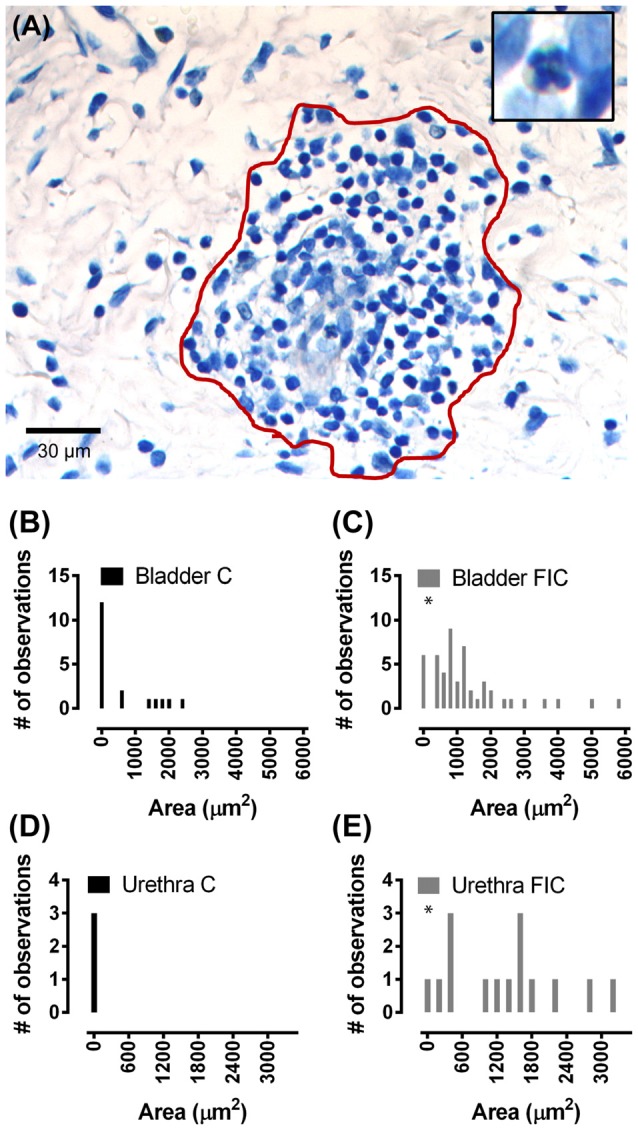
Immune cell infiltration in the LP of the bladder and urethra. (A) Example of leukocyte accumulation and area (red line) used for quantification, in the bladder of a FIC cat. Inset illustrates a neutrophil, characterized by the presence of dark small vesicles. (B,C) Histogram of area of immune cell infiltrate in the LP of the bladder from control (black; n = 17) and FIC (gray; n = 13) cats (Kolmogorov-Smirnov test, p = 0.02) cats showing only values smaller than 6000 μm2. One measurement in control and two measurements in FIC tissue were larger than 6000 μm2. Bin size 200 μm2. (D,E) Histogram of area of immune cell infiltrate in the LP of the urethra of control (black; n = 3) and FIC (gray; n = 7) cats (Kolmogorov-Smirnov test, p = 0.02) showing only values smaller than 3500 μm2. Bin size 200 μm2. There was no immune cell infiltrate in the urethra of control cats (black bar centered at 0; n = 3 cats). Three measurements in FIC tissue were larger than 3500 μm2. Statistical significance was tested using Kolmogorov-Smirnov test. Asterisk (*) indicates p < 0.05.